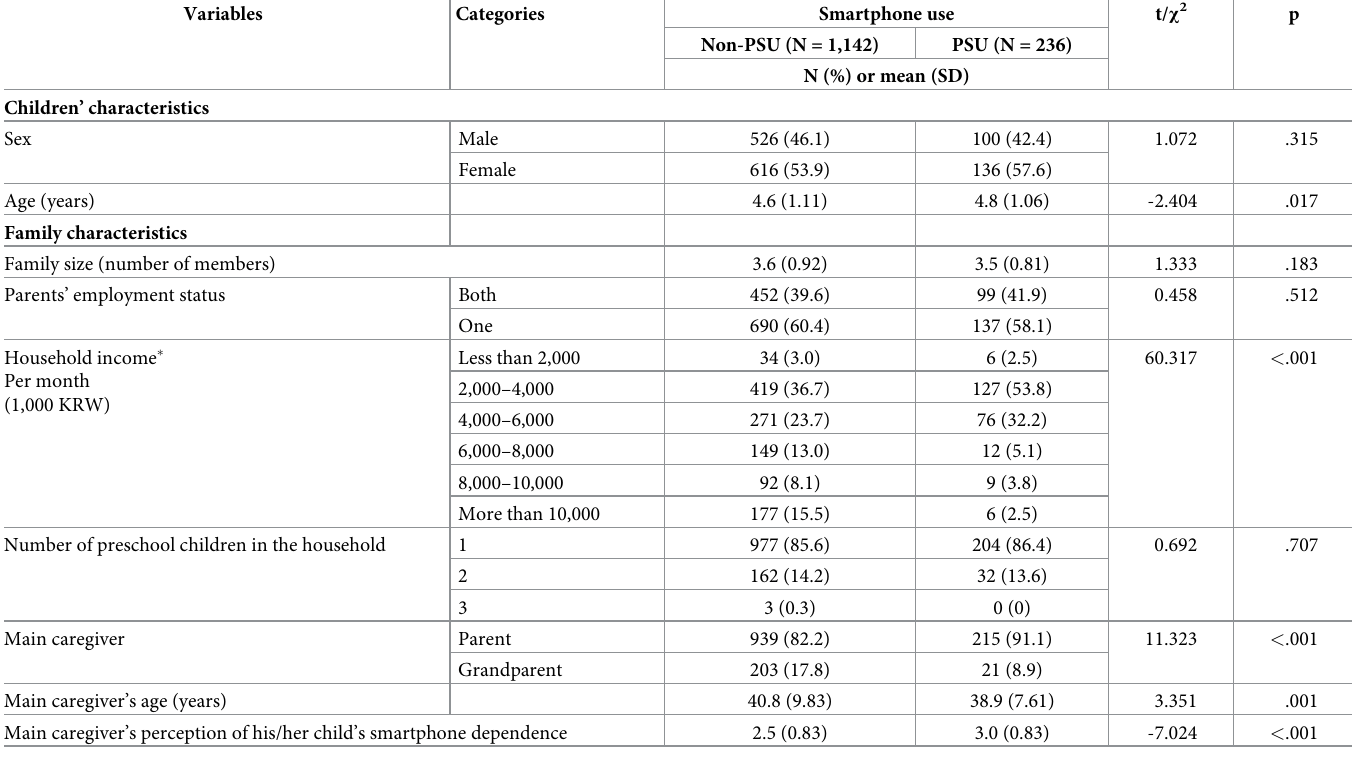
Table 1. Differences between non-PSU and PSU according to the characteristics of the children and families (N =